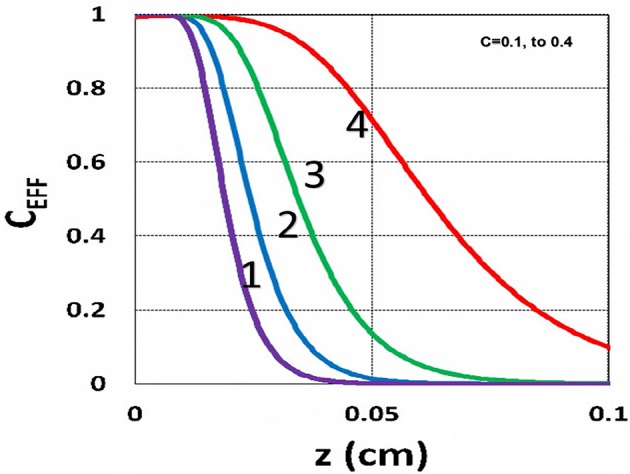
Efficacy spatial profiles. Same as Figure 11, but for C0 = (0.1, 0.2, 0.3, 0.4) mM, for curves (1, 2, 3, 4); for I0 = 15 mW/cm2, at t = 400 s.